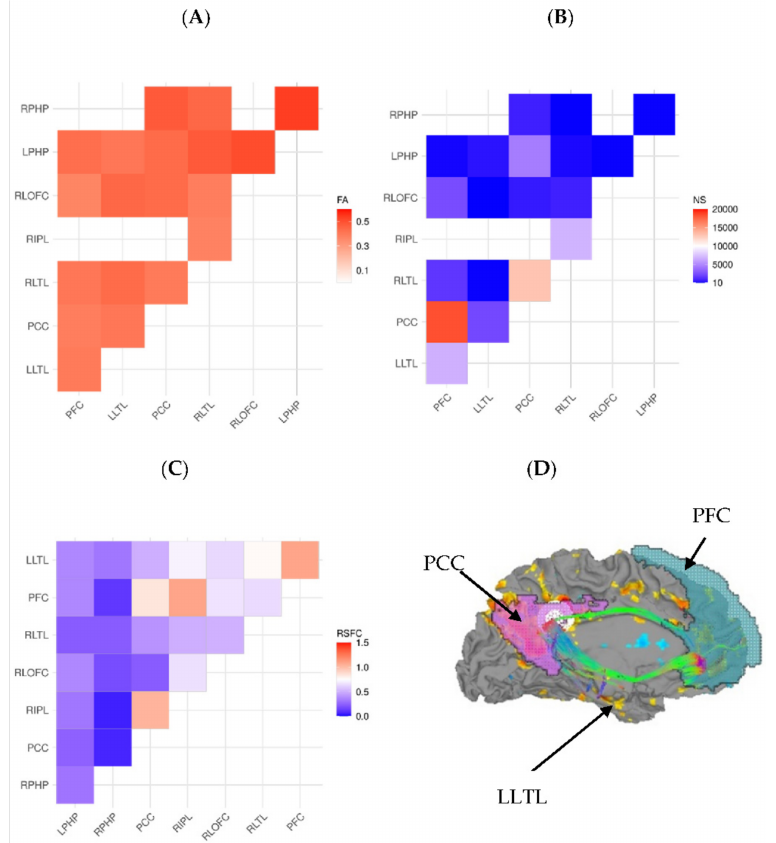
Figure 1. ( A ) FA for ROI-to-ROI tracts, ( B ) number of tracts for ROI-to-ROI pairings, ( C ) resting state functional connectivity connectomes for the default mode network of a representative participant. ( D ) Brain surface map, showing RSFC (yellow-blue color scheme) and superimposed tract (in green) for cingulate nodes of the DMN, projected onto the left medial surface of the brain in a representative subject. Labels for regions of interest are: LLTL = left lateral temporal lobe, PCC = posterior cingulate cortex, and PFC = prefrontal cortex.